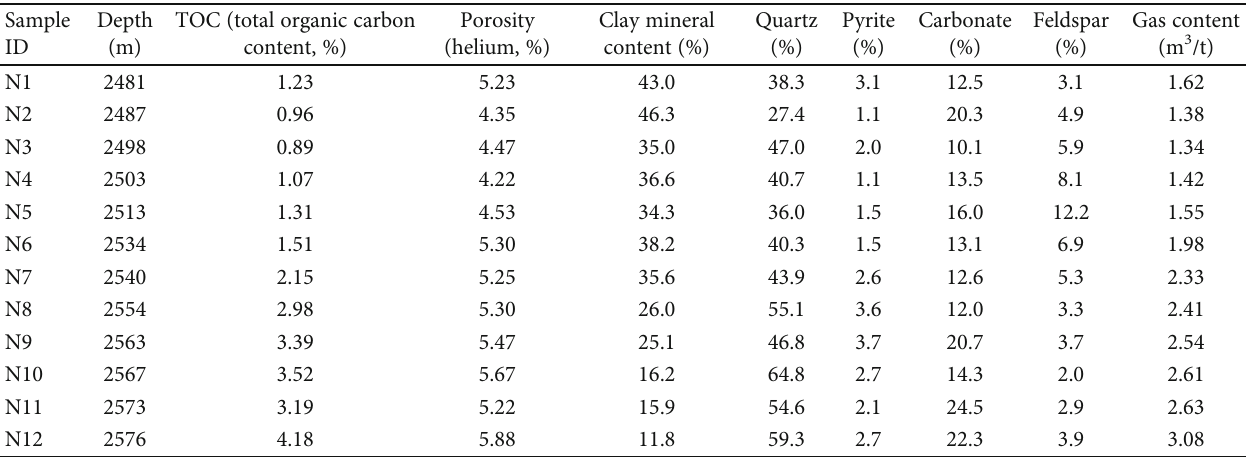
Table 1: Lists of Wufeng-Longmaxi shale samples from Sichuan Basin and their depths, porosities, total organic carbon (TOC) contents, and mineral contents. Gas contents are also included. Gas contents include lost gas, desorbed gas, and remaining